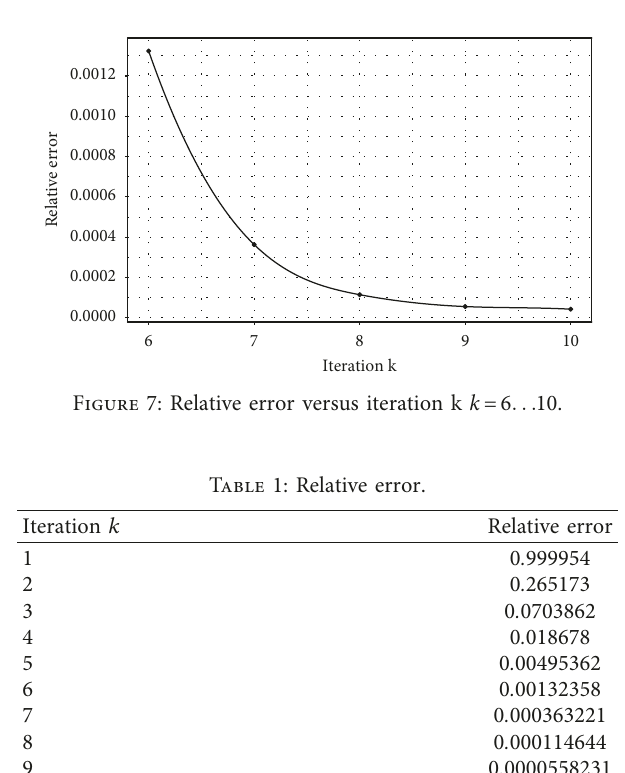
Figure 4: The magnitude of the difference between exact and approximate solutions for k � 1 and 9. For k � 1, range is 0 . 02 − 0 . 16; for k � 9, range is 1 . 0 × 10 − 6 − 6 . 0 × 10 − 6 .